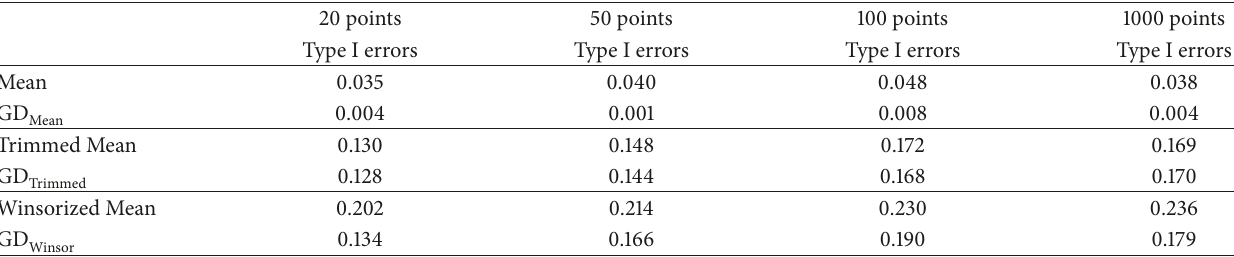
Table 44: Contaminated 𝜒 2 distributions with 30% noise level.